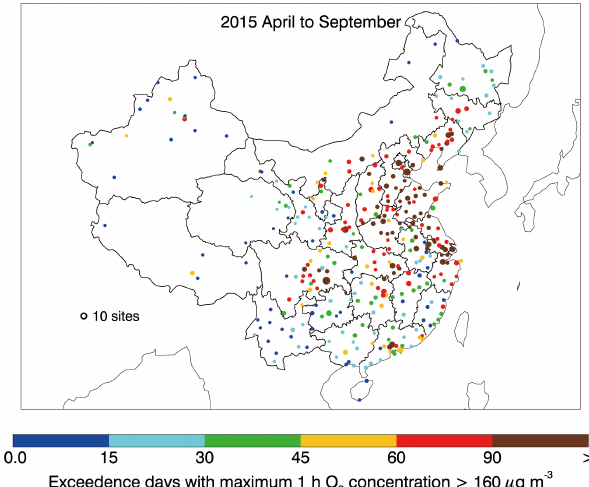
Figure 4. Distribution of days with the maximum 1h [O 3 ] exceed- ing 160µgm − 3 in mainland China from April to September 2015.